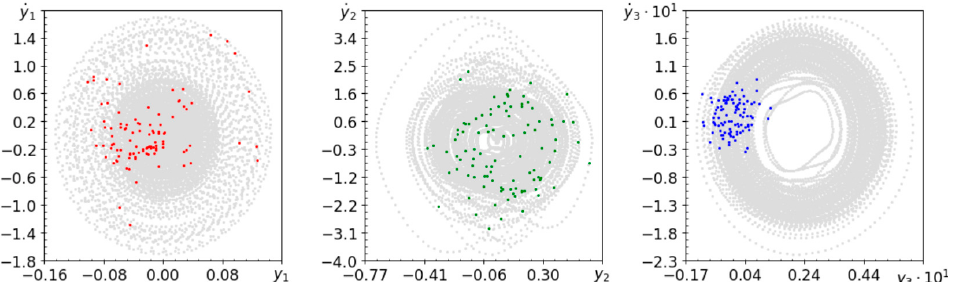
Figure 10. Phase planes (gray lines) and Poincar é maps (red, green and blue dots) for C = 0.05, k = 40 and ω = 2.84.